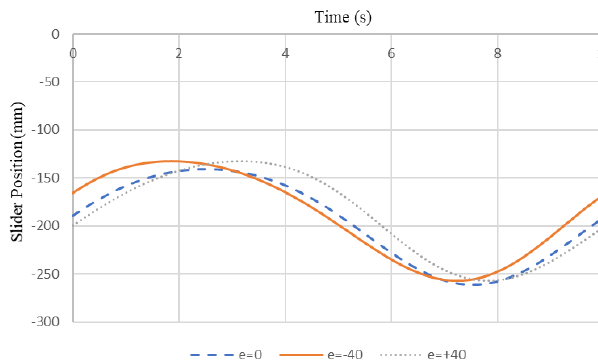
Figure 6. The graph of slider position.